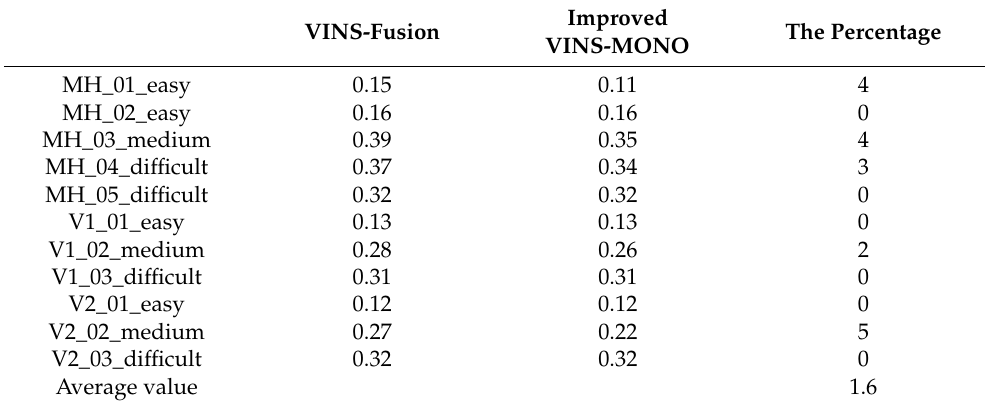
Table 18. Compare the accuracy of VINS -Fusion algorithm with the improved algorithm in the EuRoC dataset (Unit: meter).